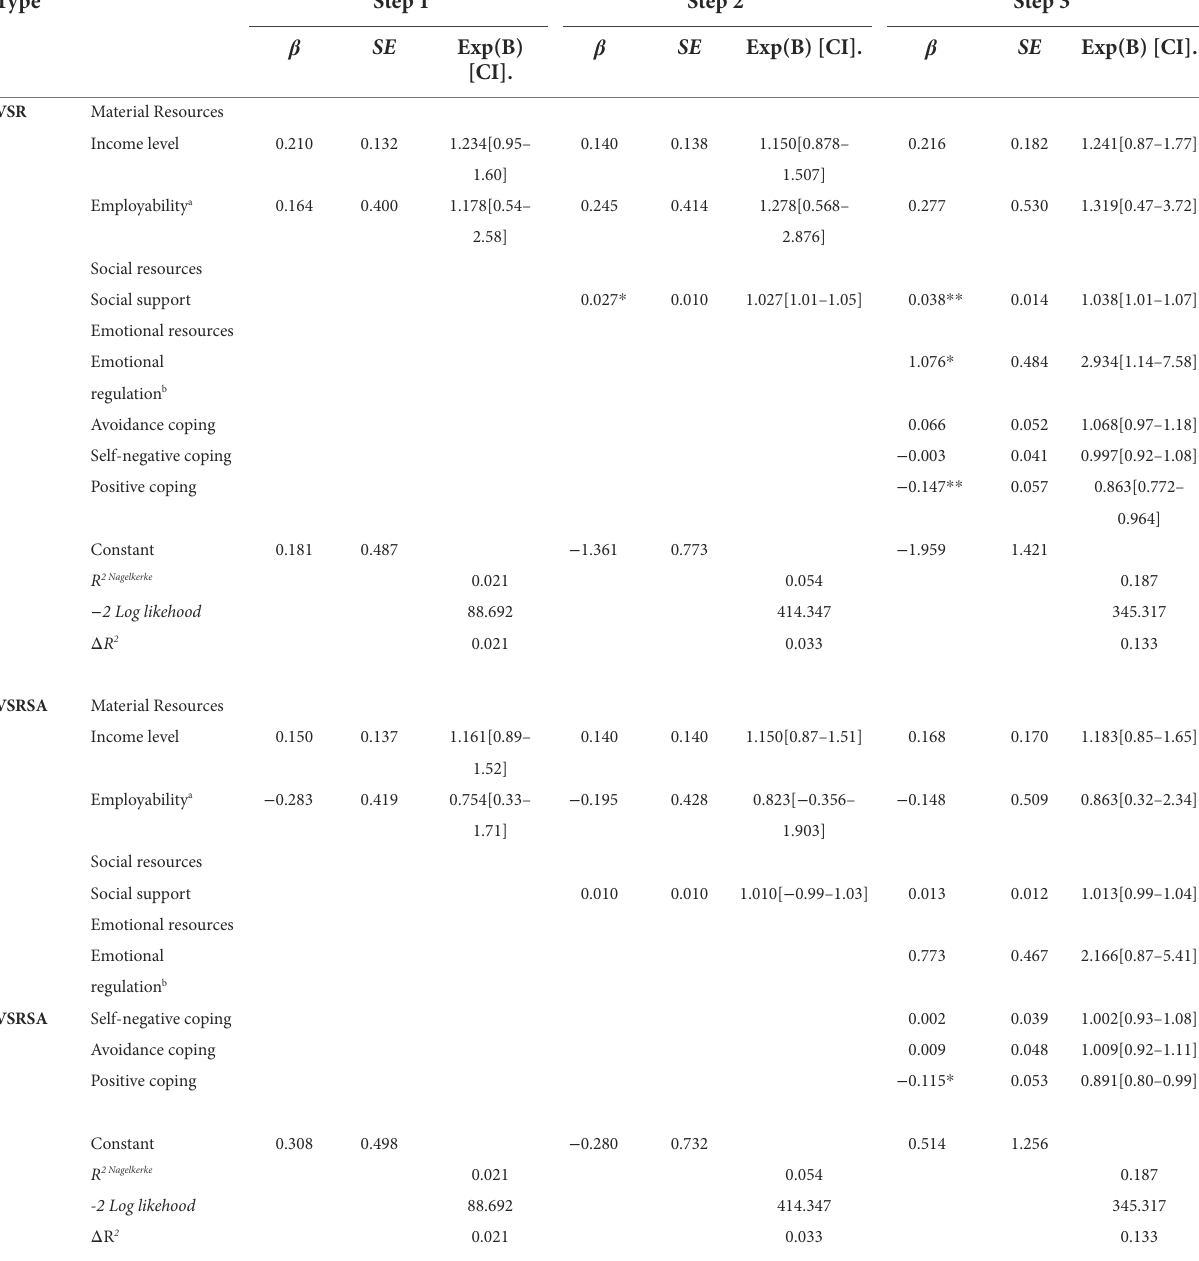
TABLE 4 Hierarchical multinomial logistic regression using VSRDA as the reference